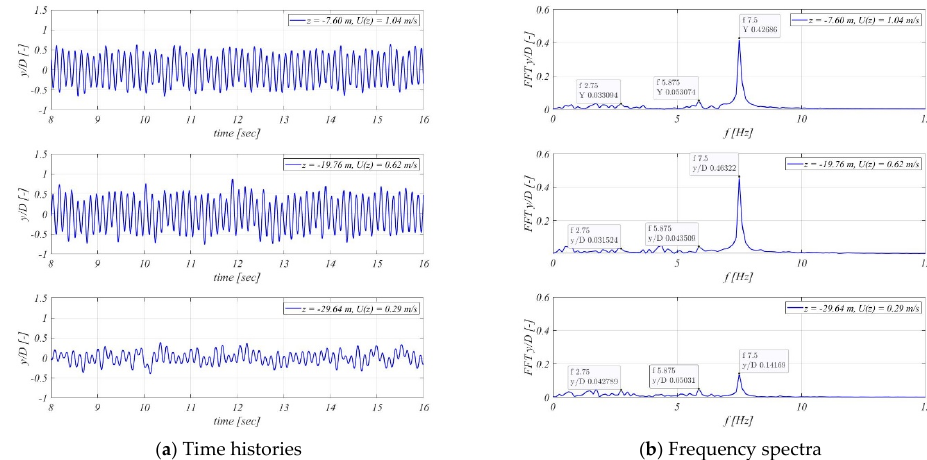
Figure 21. Responses at three points (near the top, middle, and bottom) in time and frequency domain under shear current ( U max = 1.3 m/s).